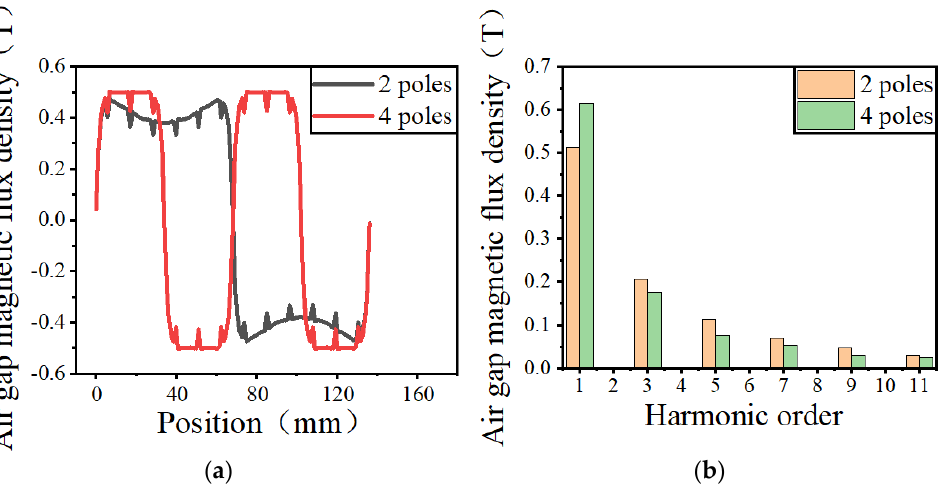
Figure 2. Waveforms and FFT analysis results of air gap magnetic flux density for 2 poles and 4 poles HSPMMs. ( a ) Waveforms; ( b ) FFT analysis results.